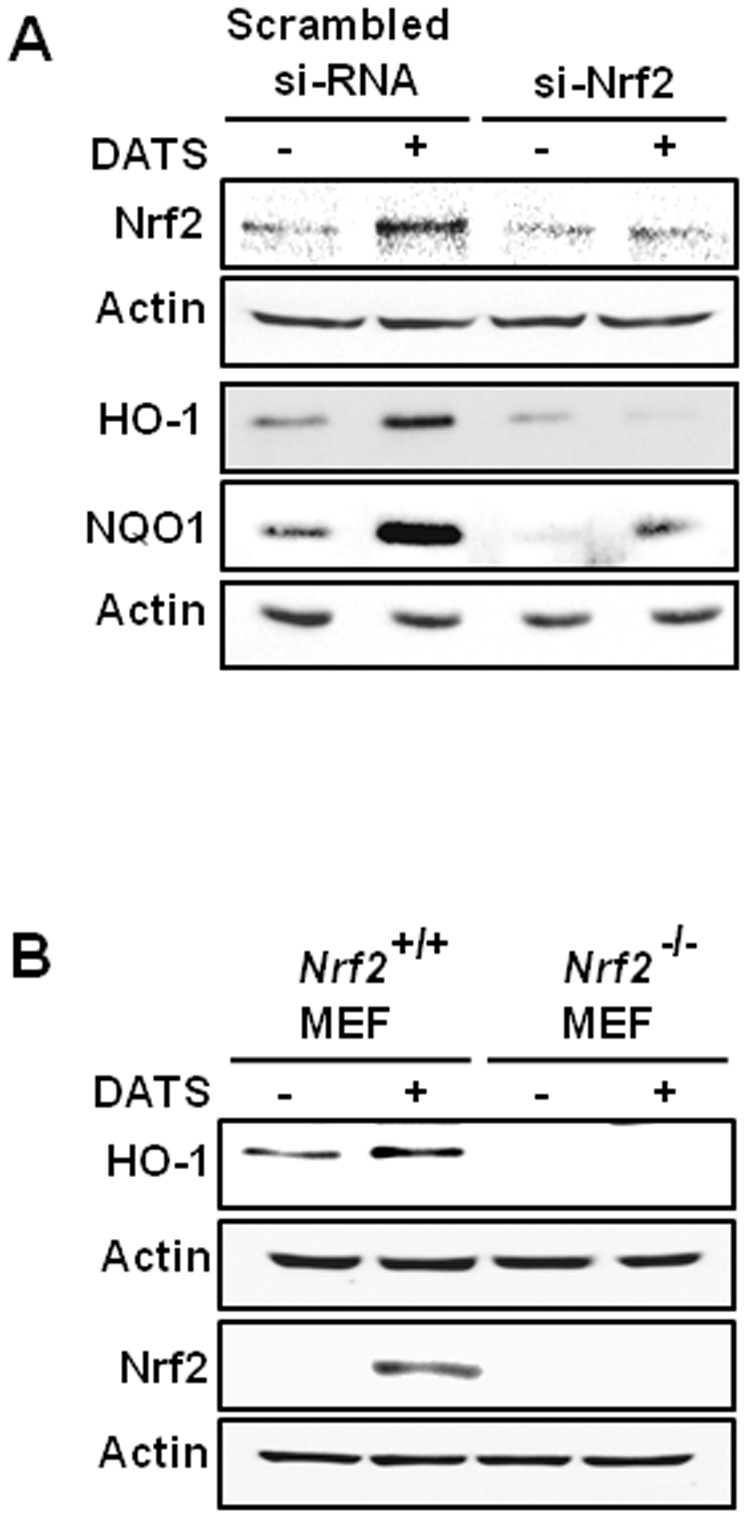
Knockdown of Nrf2 abrogates DATS-induced expression of HO-1 and NQO1.Cells transfected with Nrf2-siRNA or nrf2-null MEFs were incubated with 20 µM of DATS for 1 h or 6 h, respectively, to determine the levels of Nrf2 or its target protein HO-1 and NQO1. Cells were harvested and the protein lysate was subjected to Western blot analysis. The incubation conditions and other experimental details are described in Experimental procedures.